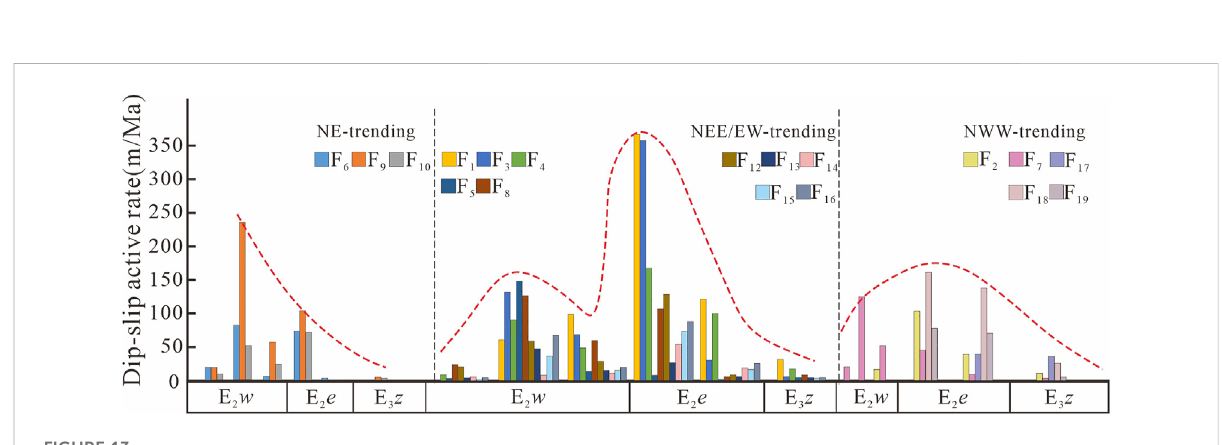
FIGURE 13 Average rates of active dip-slip faulting of main faults in the Yangjiang